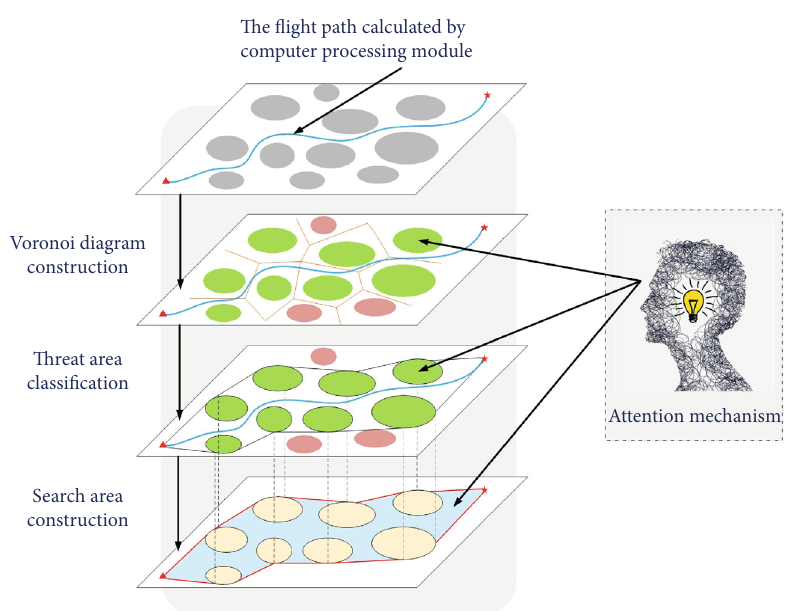
Figure 9: Space clipping operation based on attentional mechanism.